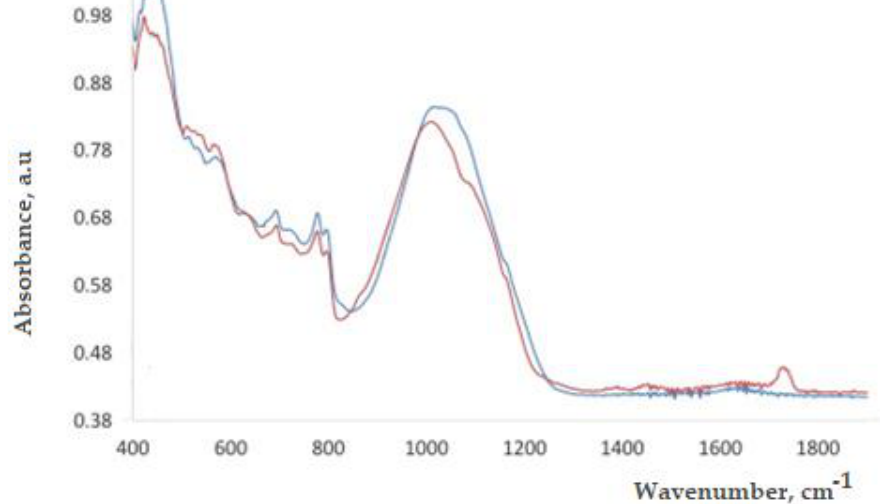
Figure 10. FTIR spectra of the red substrate and white deposits (encrustation) (red line - white powder; blue line - red ceramic).